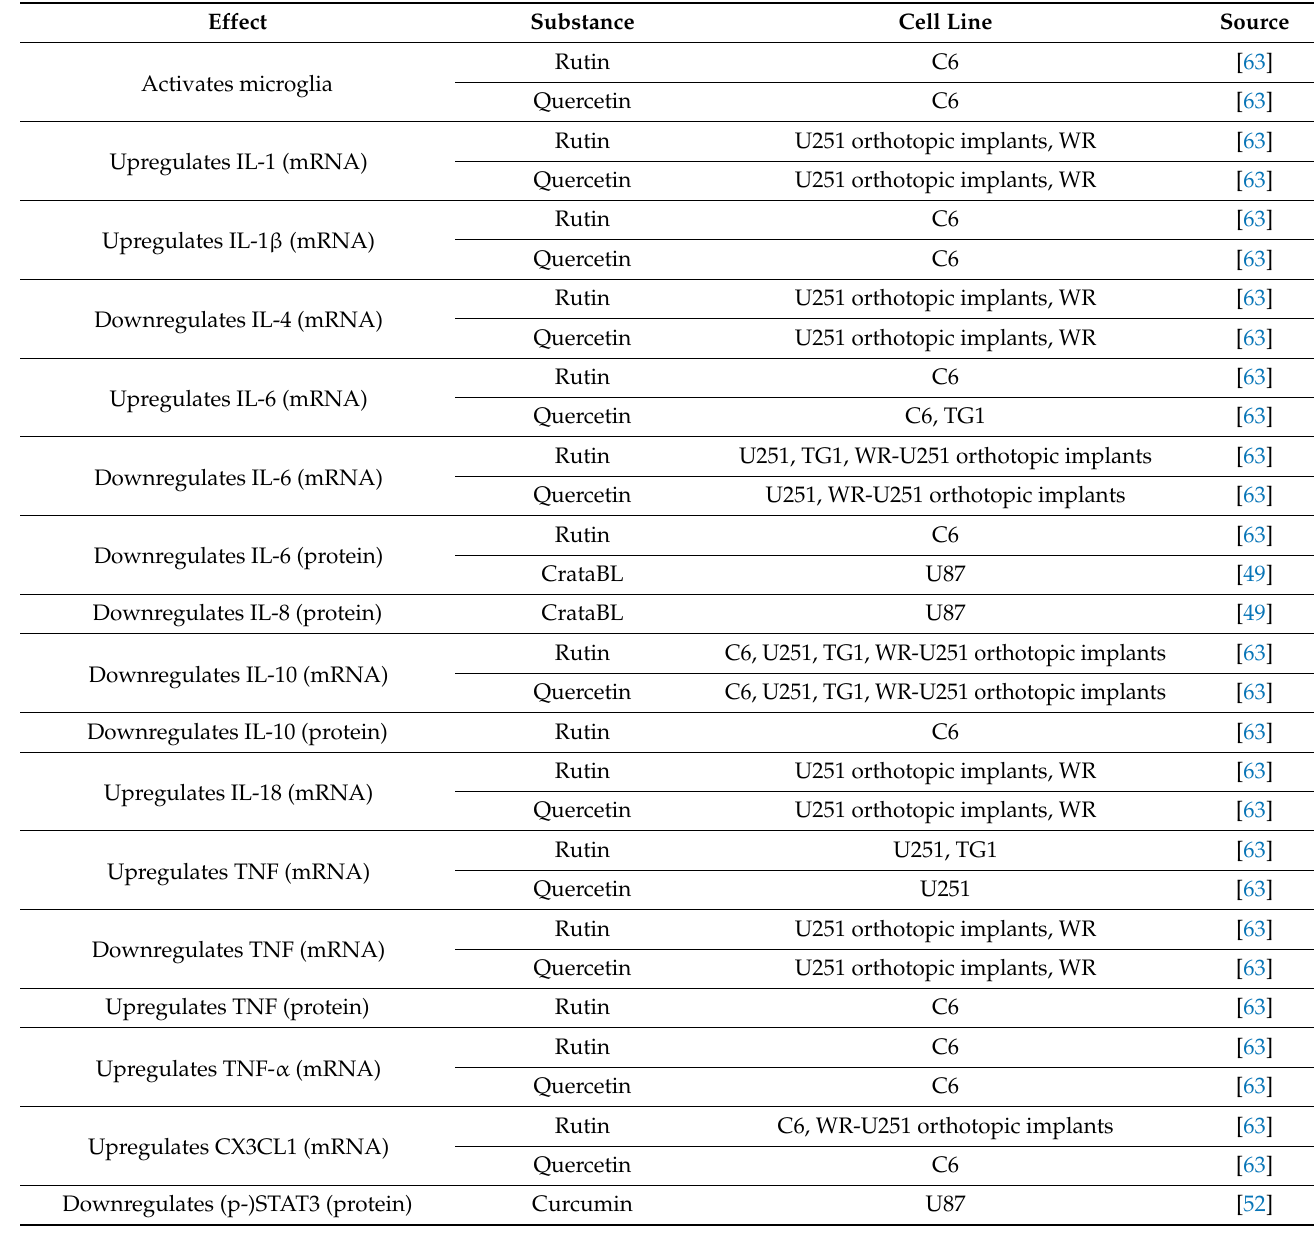
Table 7. Rutin, quercetin, and CrataBL exert pleiotropic and sometimes cell line-dependent effects on